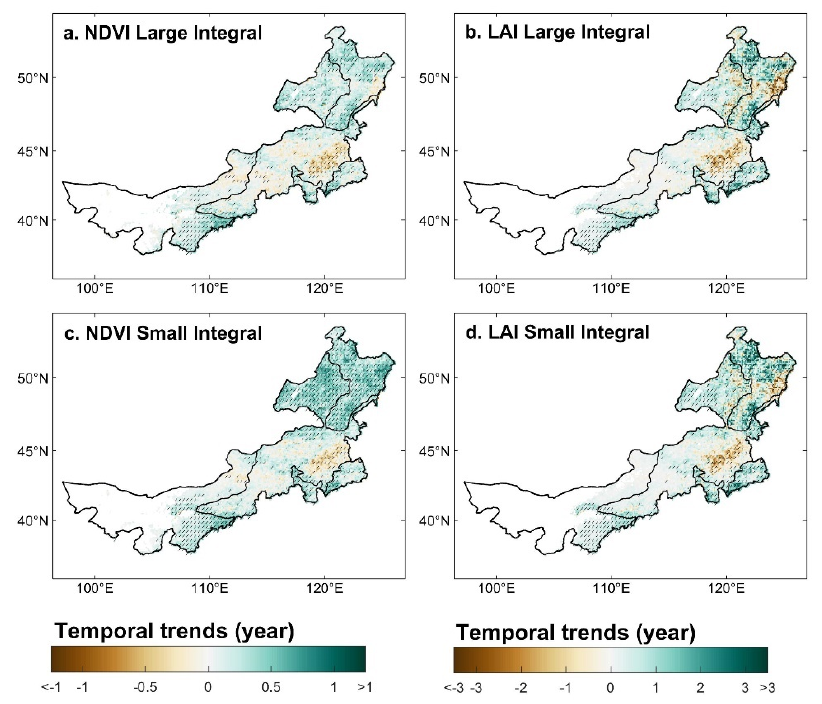
Figure 4. Spatial patterns of NDVI/LAI integrals from 1982 to 2016 in Inner Mongolia. ( a ): NDVI large integral; ( b ): LAI large integral; ( c ): NDVI small integral; (d): LAI small integral. Hatched regions suggest significant changes at the 95% confidence level ( t -test). No data (i.e., non-vegetated areas or missing data) are reported in white.